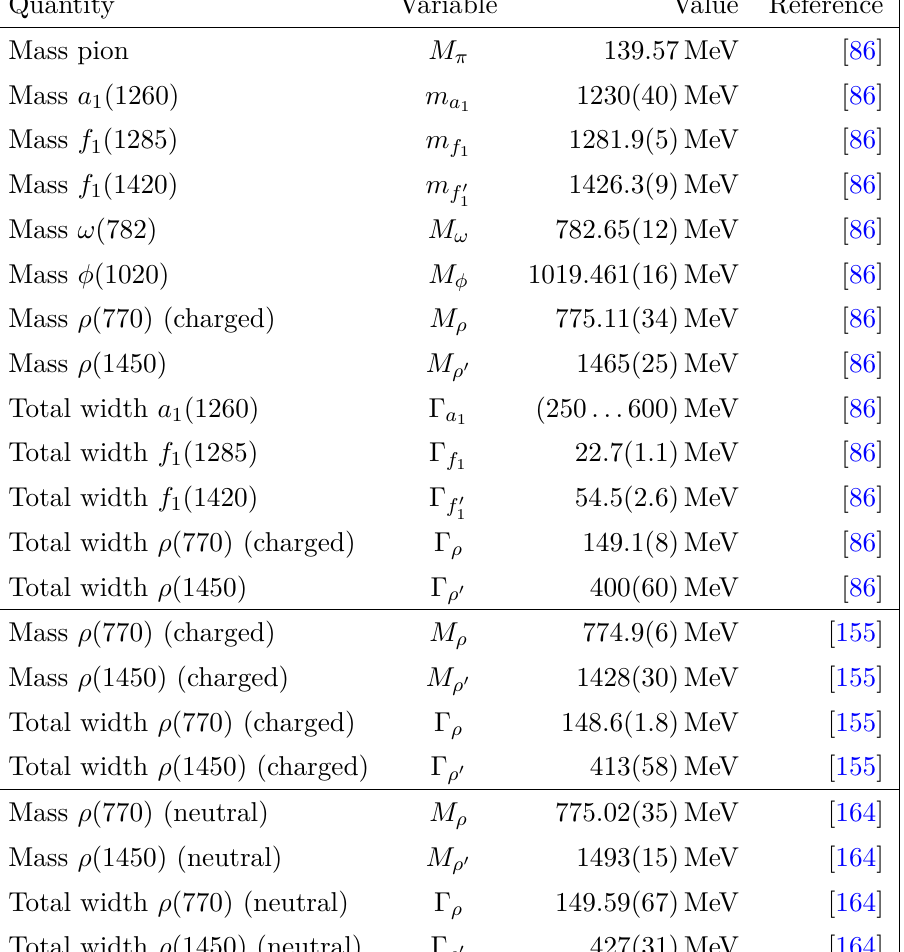
Table 10 . Selected masses and decay widths from ref. [86], in comparison to the ρ (770) and ρ (1450) parameters from refs. [155,